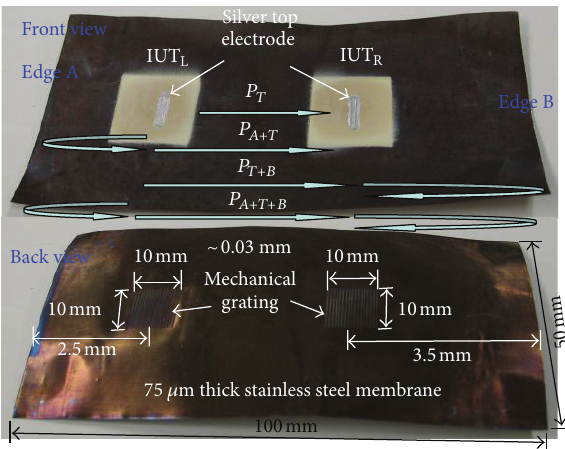
Figure 10: Two 62 𝜇 m thick piezoceramic films are sprayed onto a 75- 𝜇 m thick stainless steel (SS) membrane to form two IUTs (upper pane). On the other side of the membrane and opposing each IUT, a grooved grating is made with electrical discharge machining (EDM) (lower pane). Each grating is composed of seventeen 0.3 mm wide, ∼ 0.03 mm deep, 10 mm long, and 0.6 mm equidistant